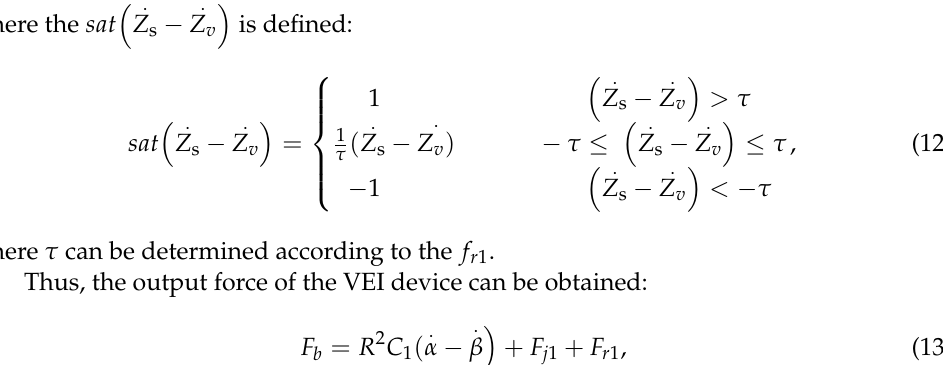
249 Figure 9. Force-displacement characteristics of VD device.